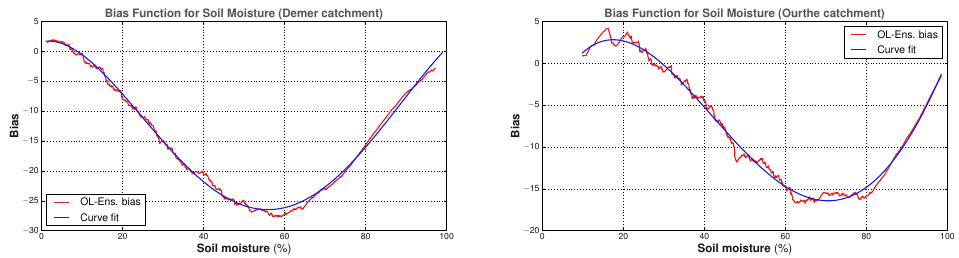
Figure 6. Bias functions for SSM based on the CDFs for the period 2010–2015 (original data and curve